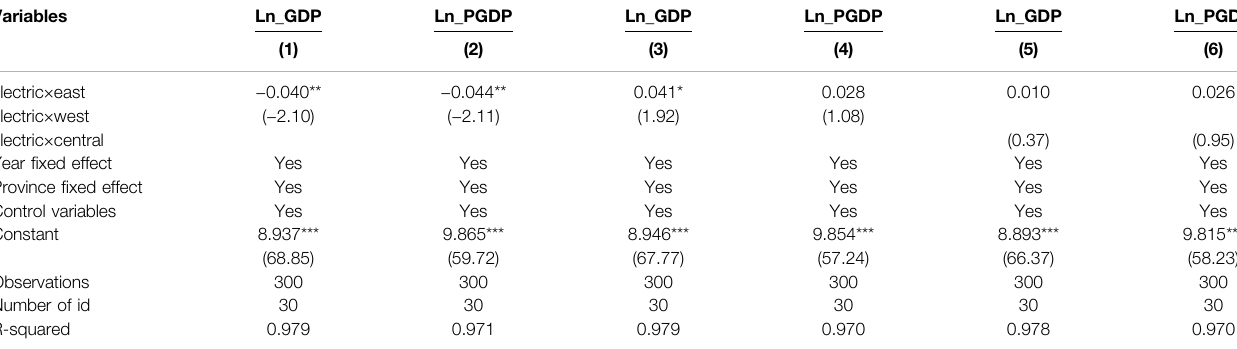
TABLE 5 | Heterogeneity analysis.